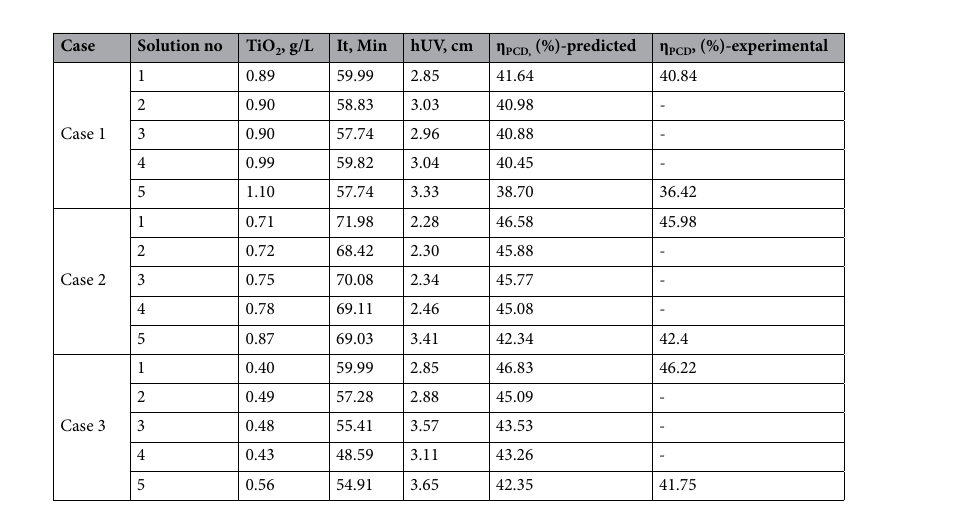
Table 6. DE optimization results for PCD of BL.